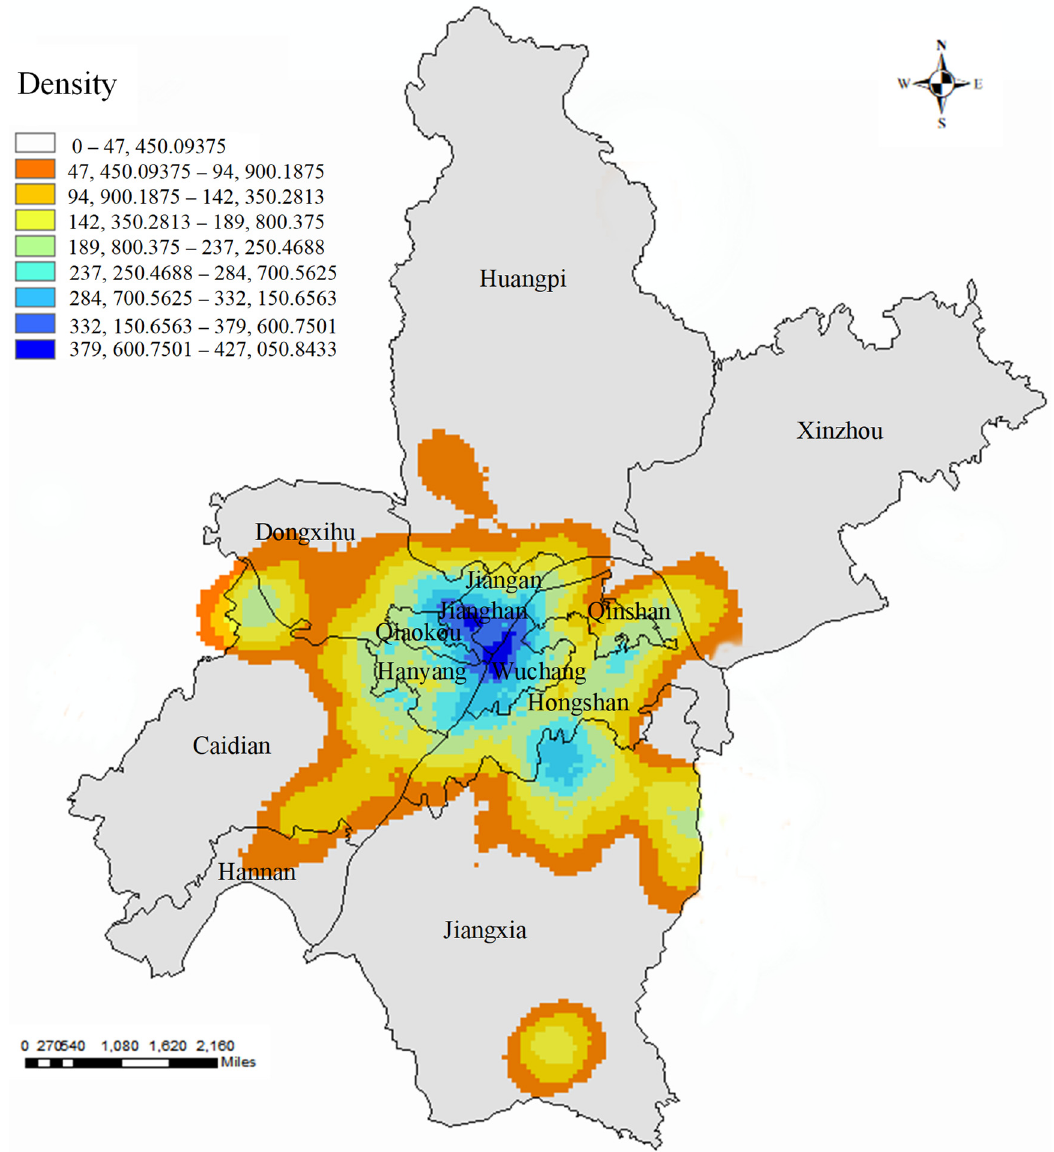
Figure 12. Distribution density of public transportation in each district of Wuhan city.